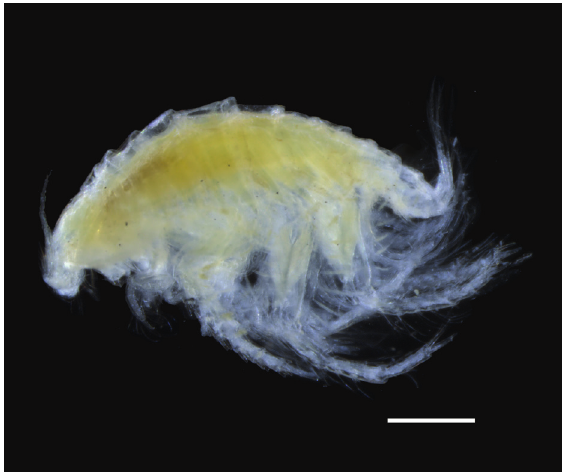
Figure 16 - Puelche mourae sp. nov. Female, MNRJ 28986: Habitus. Scale = 0.5